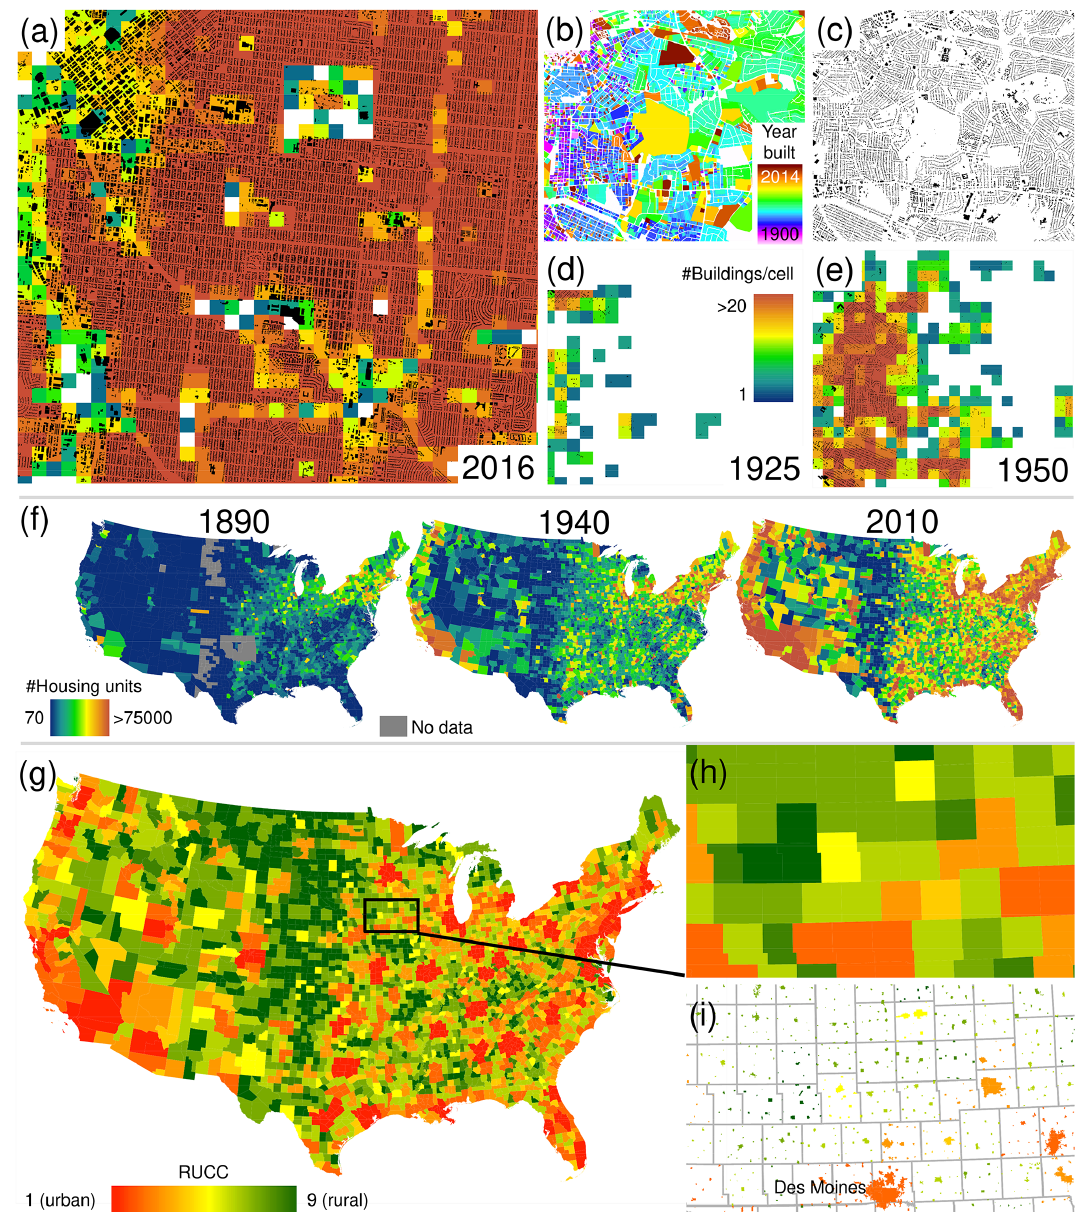
Figure 5. Datasets used for validation of the created surfaces: (a) contemporary US-wide building count surface, generated from the Mi- crosoft building footprint data (overlaid) by aggregating to grid cells of a 250m spatial resolution, shown for downtown Denver, Colorado; (b, c) multi-temporal building footprint data available for 30 counties in the USA, shown for a region in Charlotte, North Carolina; (d, e) re- sulting building count surfaces for 1925 and 1950, respectively; and (f) US-census-based dwelling statistics for US counties in 1890, 1940, and 2010. (g) County-level USDA rural–urban continuum codes (RUCCs) in 2013; (h) enlargement of the county-level RUCC data around Des Moines (Iowa); (i) RUCCs attached to US-census-designated places in 2010 for the same